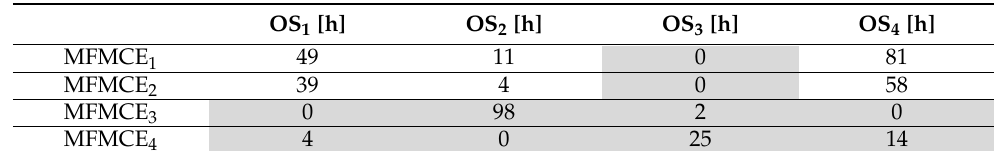
Table 5. Cross combination with minimum zero lines.